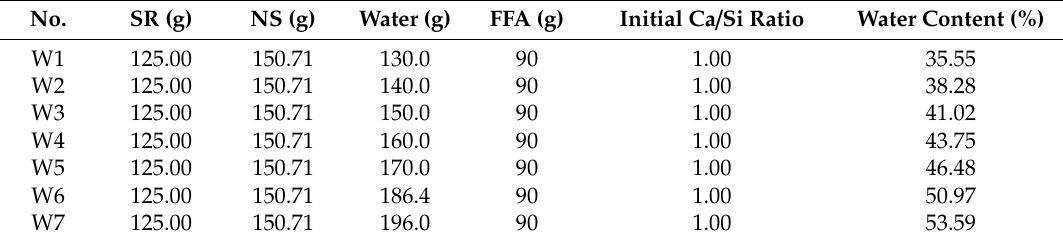
Table 4. Mass mixing proportions of backfill paste about the influence of water content on 7 d UCS.